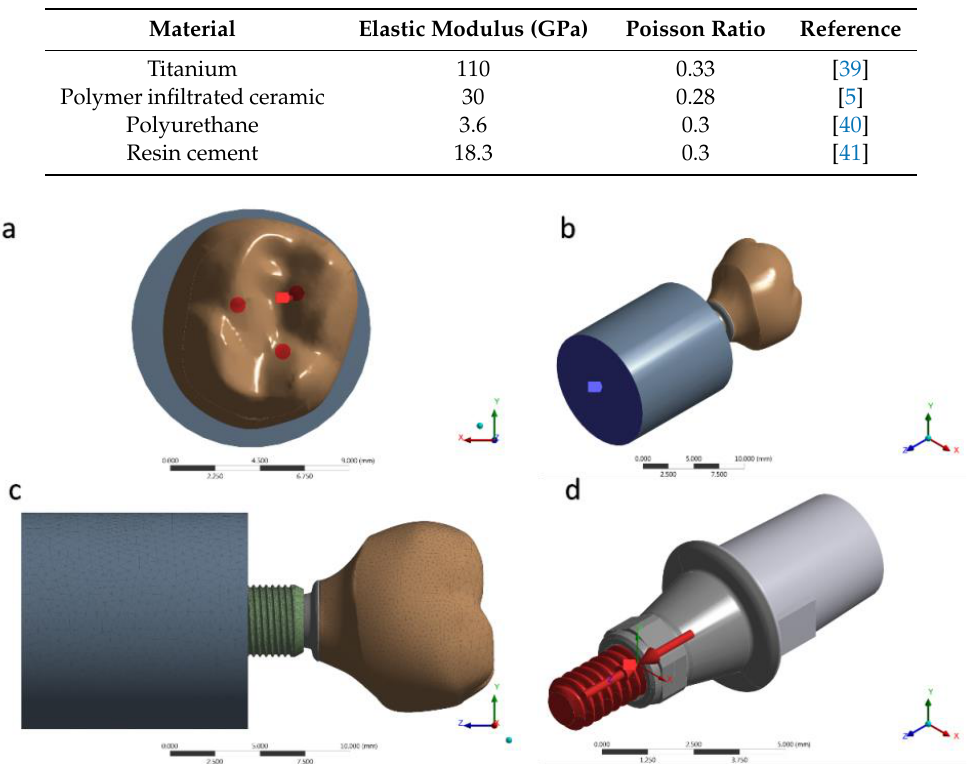
Table 1. Mechanical properties of the materials used in this study.